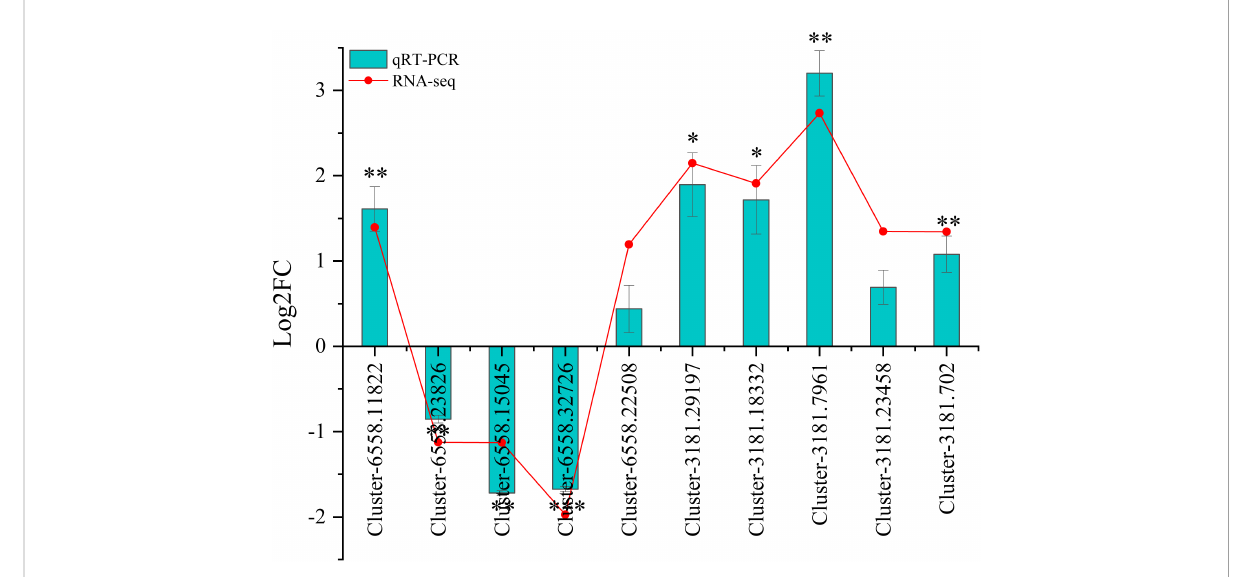
FIGURE 8 Relative expression via qRT-PCR and RNA-seq of 10 DEGs. Signi fi cance was de fi ned as *(P < 0.05), **(P < 0.01), and ***(P < 0.001).